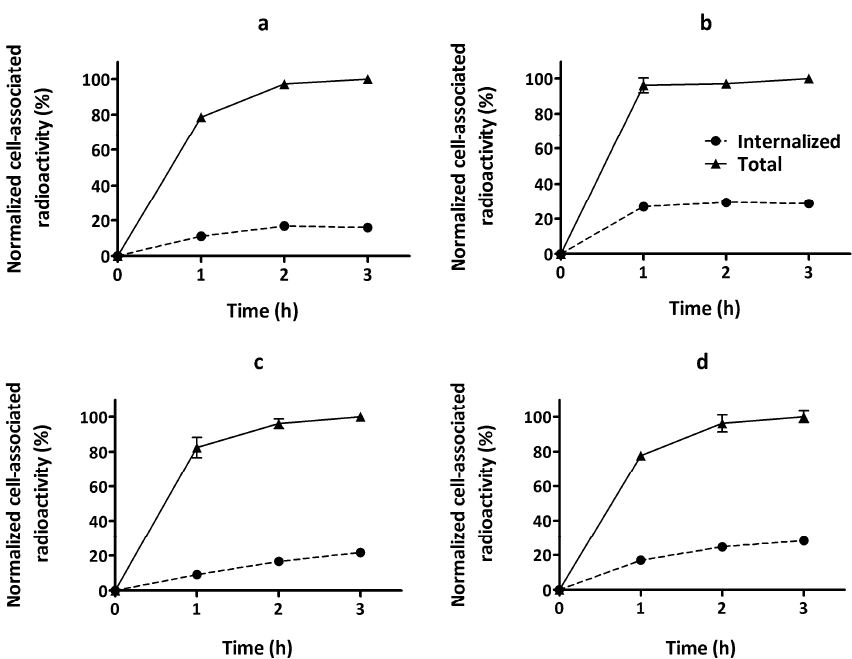
Figure 5. Cellular processing of DFO-ZEGFR:2377 labeled with gallium-68 ( a ) at RT by A431, ( b ) at RT by PC3, ( c ) at 85 °C by A431, and ( d ) at 85 °C by PC3. Cells were incubated with 5 nM [ 68 Ga]Ga-DFO-ZEGFR:2377 conjugate. Cell-associated activity was normalized to the maximum uptake. The data are presented as average (n = 3) and SD. Error bars might not been seen because they are smaller than the symbols.